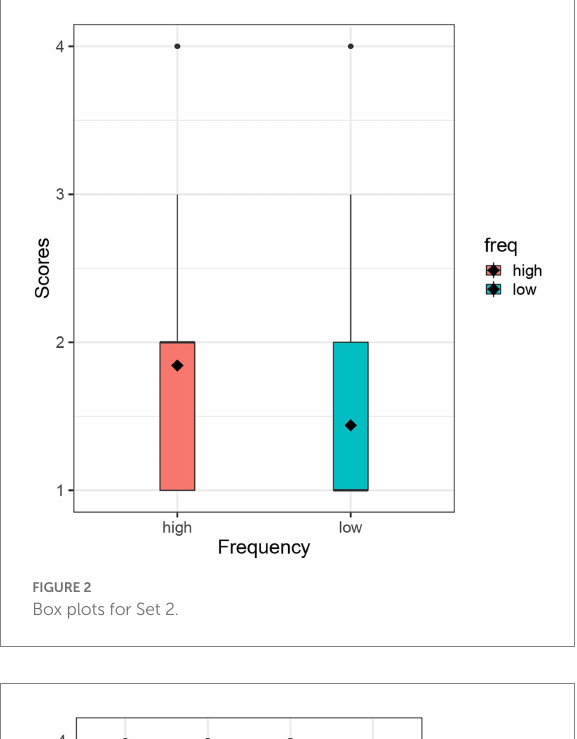
TABLE 3 Model summary.